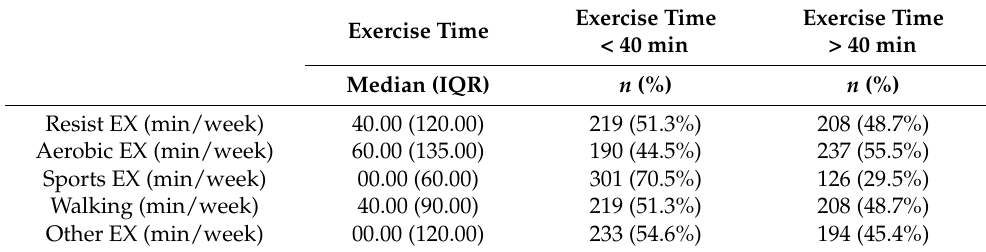
Table 2. Descriptive characteristics of exercise time for different exercise types.